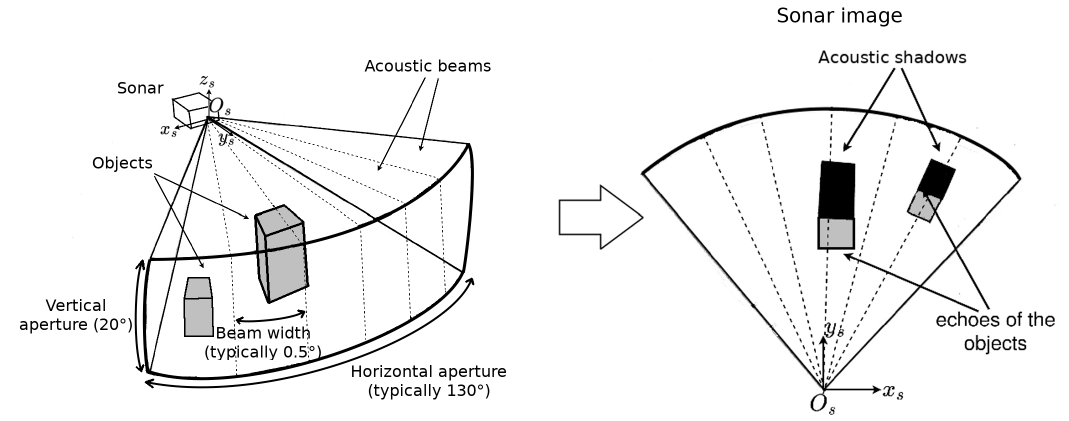
Figure 4. Illustration of the principle of a multibeam imaging sonar. The sensor produces wide acoustic beams, which are reflected by the objects they reach. The echoes are then received by an array of transducers forming many beams. The echoes create bright points in the acoustic image. The areas located behind the objects do not receive any sound, thus creating dark zones, corresponding to the acoustic shadows. The length of the shadow generally depends on the object’s height.